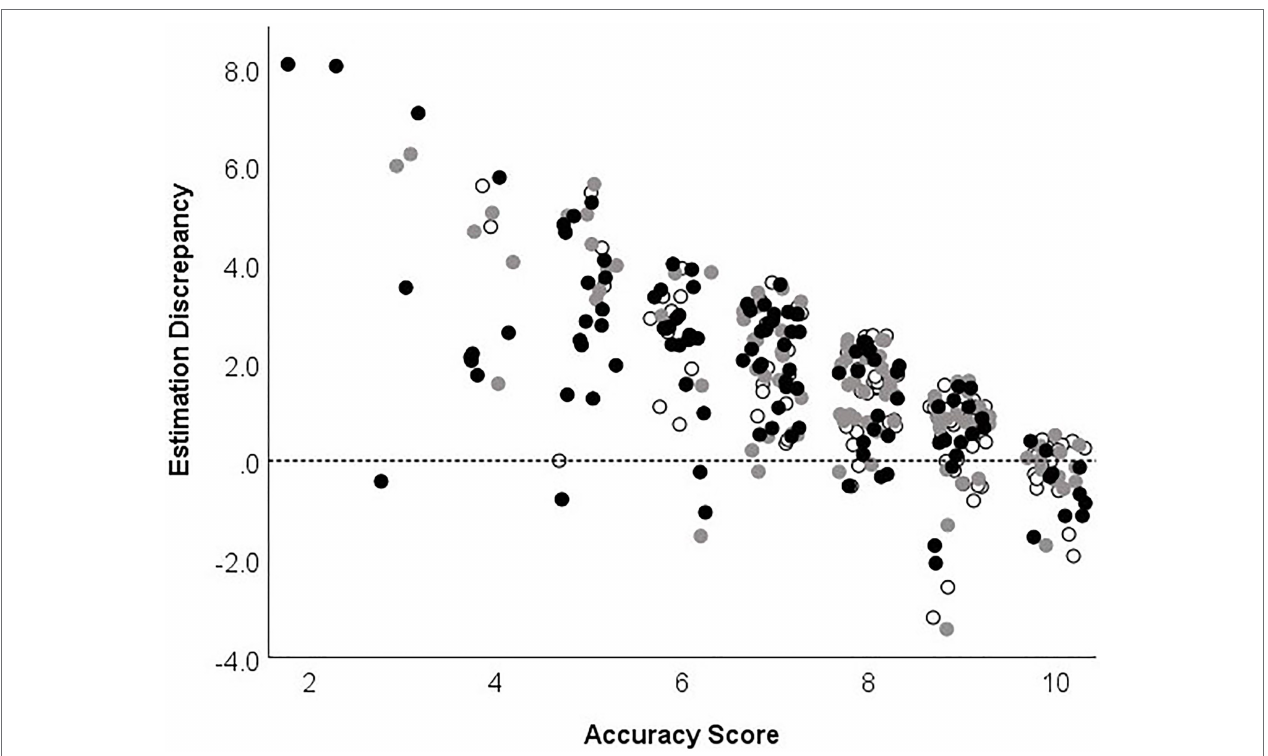
FIGURE 2 | Association between estimation discrepancy and accuracy across the adult lifespan. Dotted line indicates perfect alignment between estimated accuracy and actual accuracy.